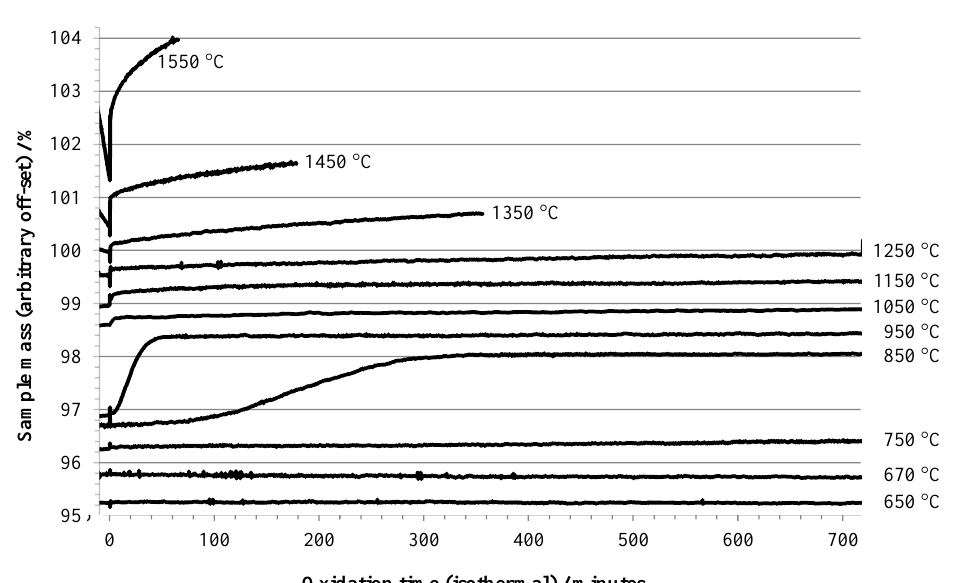
Figure 1. TGA results for 0.5 mm aluminum heated under argon to the indicated temperature, then exposed to air (at t = 0).